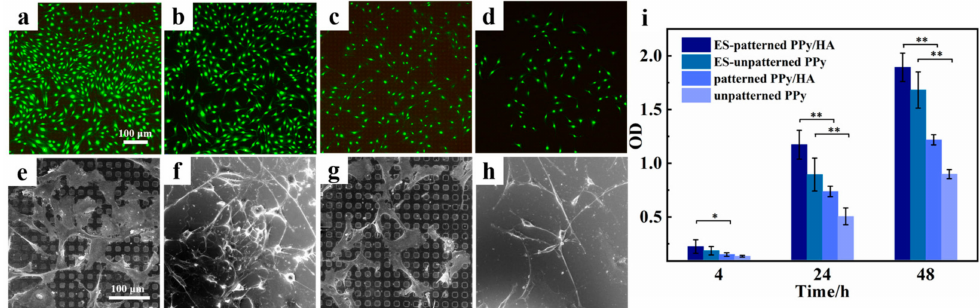
Figure 5. ( a – d ) Fluorescence images of MC3T3-E1 cells cultured on different materials for 24 h; ( a ) Micropatterned PPy/HA composite coatings with ES; ( b ) Unpatterned PPy with ES; ( c ) Micropat- terned PPy/HA composite coatings without ES; ( d ) Unpatterned PPy without ES; ( e , f ) SEM images of MC3T3-E1 cells cultured on different materials for 24 h; ( e ) Micropatterned PPy/HA composite coatings with ES; ( f ) Unpatterned PPy with ES; ( g ) Micropatterned PPy/HA composite coatings without ES; ( h ) Unpatterned PPy without ES; ( i ) Cell adhesion and proliferation curves of MC3T3-E1 cells on different materials. * p < 0.05, ** p <